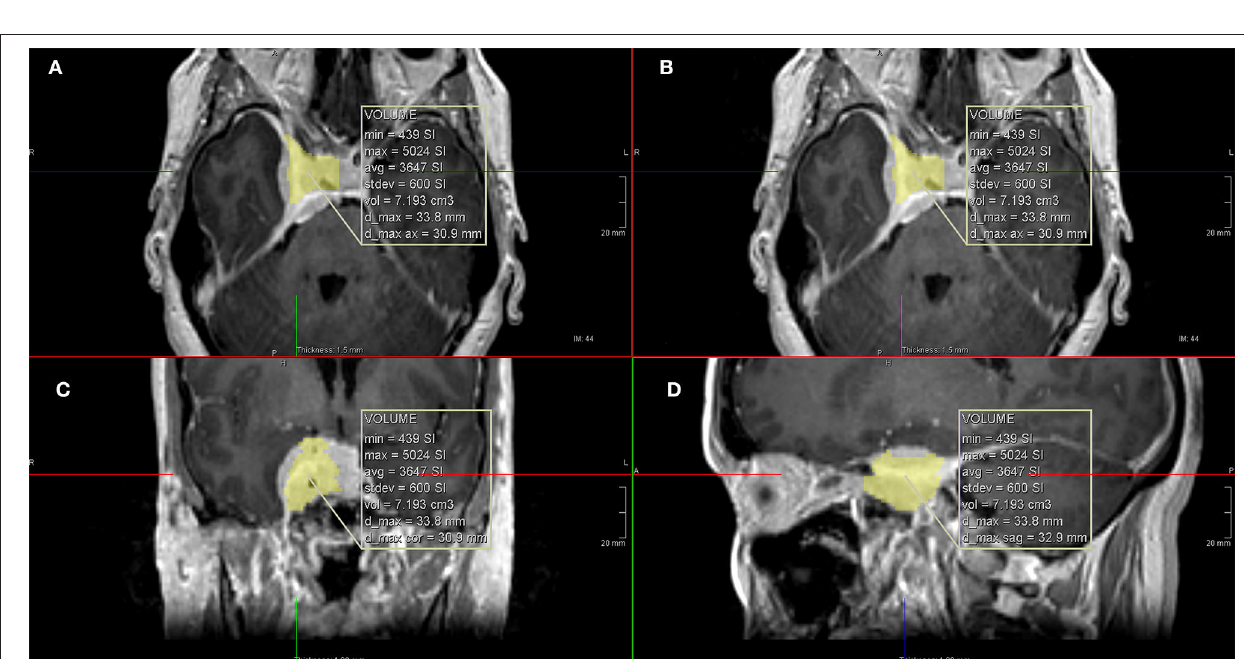
FIGURE 2 | Calculation of the intracavernous volume of tumor using computer software. (A,B) Axial T1 with gadolinium images; (C) coronal T1 with gadolinium image; (D) sagittal T1 with gadolinium image.